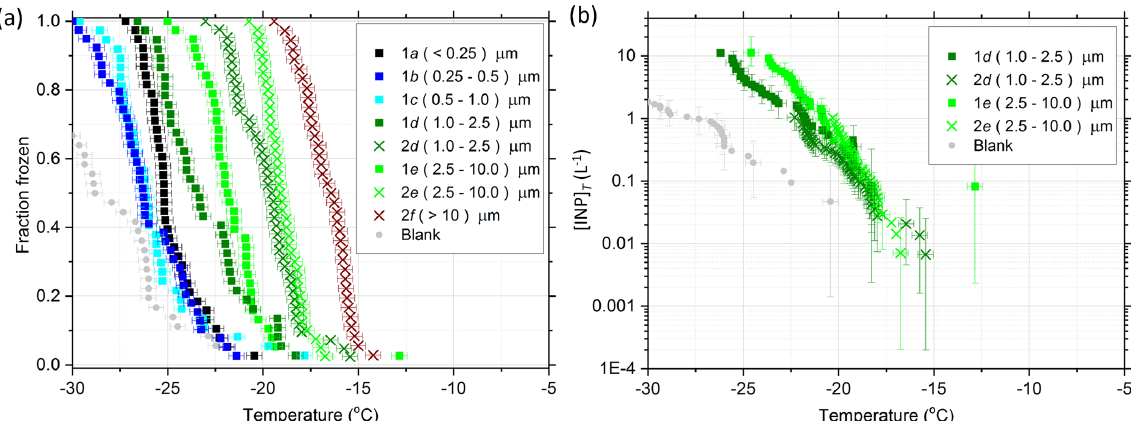
Figure 7. Ice-nucleating particle (INP) analysis of samples collected in Leeds (UK) using the SHARK. (a) The fraction of droplets frozen as a function of temperature, f ice (T ) , for each stage of Impactors 1 and 2. The handling blank is shown in grey. (b) The INP concentrations for stage “ e ” of both impactors (2.5–10µm), highlighting their excellent